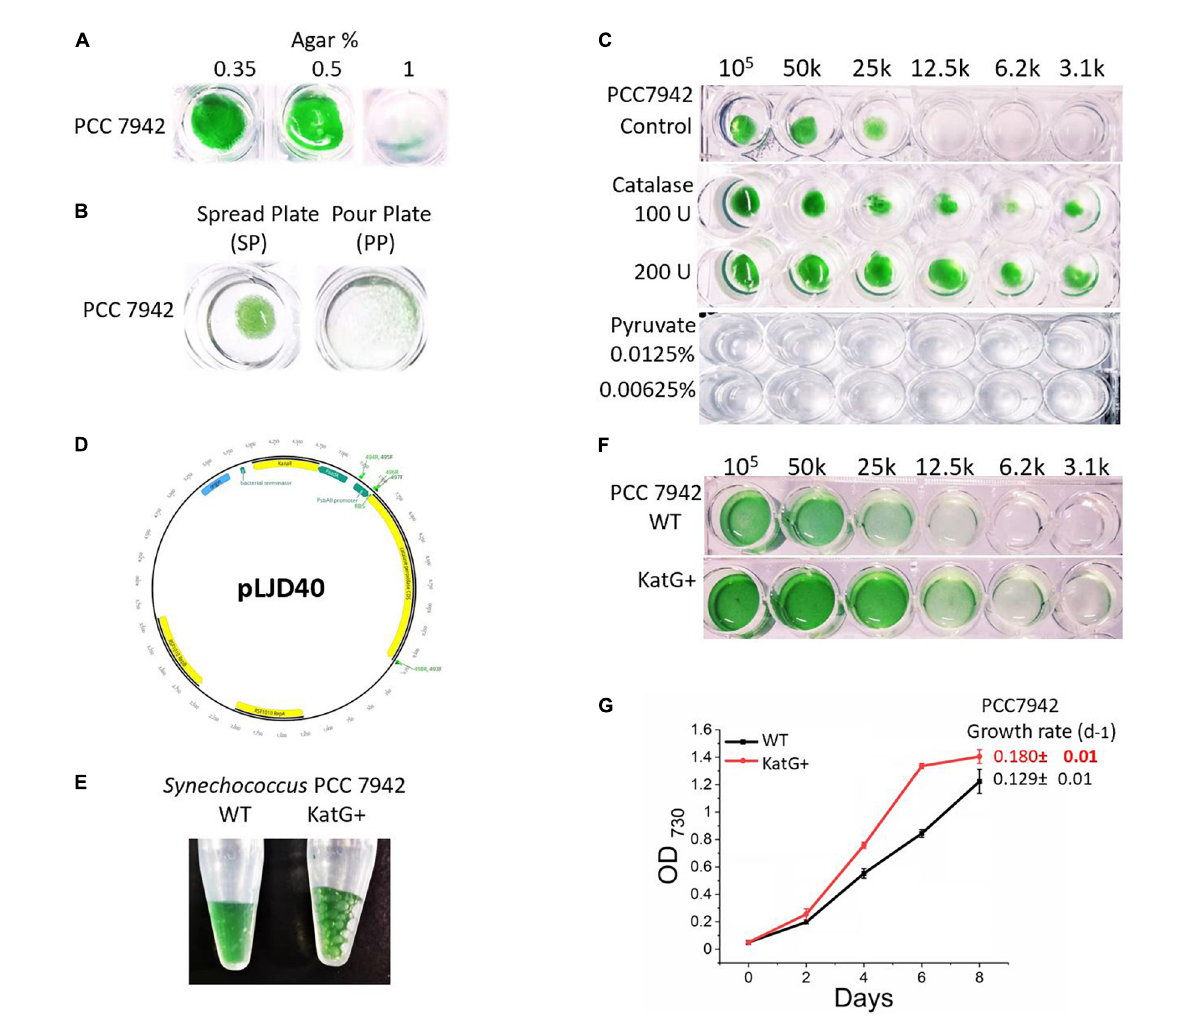
FIGURE1 Cultivation optimisation of Synechococcus 7942. (A) Growth of Synechococcus 7942 on different agar concentrations. The culture was grown for 10 days at 38 ◦ C. (B) Comparison of spread plate (SP) and pour plate (PP) plating technique on Synechococcus 7942; 0.35% agar containing BG-11 was used in both plating techniques. (C) Effect of antioxidant (external catalase) on the diluted inoculum of Synechococcus 7942; 0.35% agar containing BG-11 was used as the control, while 100 IU or 200 IU was added to 0.35% agar containing BG-11 for test conditions. (D) Plasmid map of a self-replicative vector pLJD40. KatG genes are shown in green, and Kan resistance genes are shown in yellow. (E) A catalase test result of WT and KatG + strains of Synechococcus 7942. (F) Effect of catalase on the diluted inoculum of WT and KatG + strains of Synechococcus 7942. (G) Growth curve and growth rate per day of WT and KatG + strains of Synechococcus 7942.